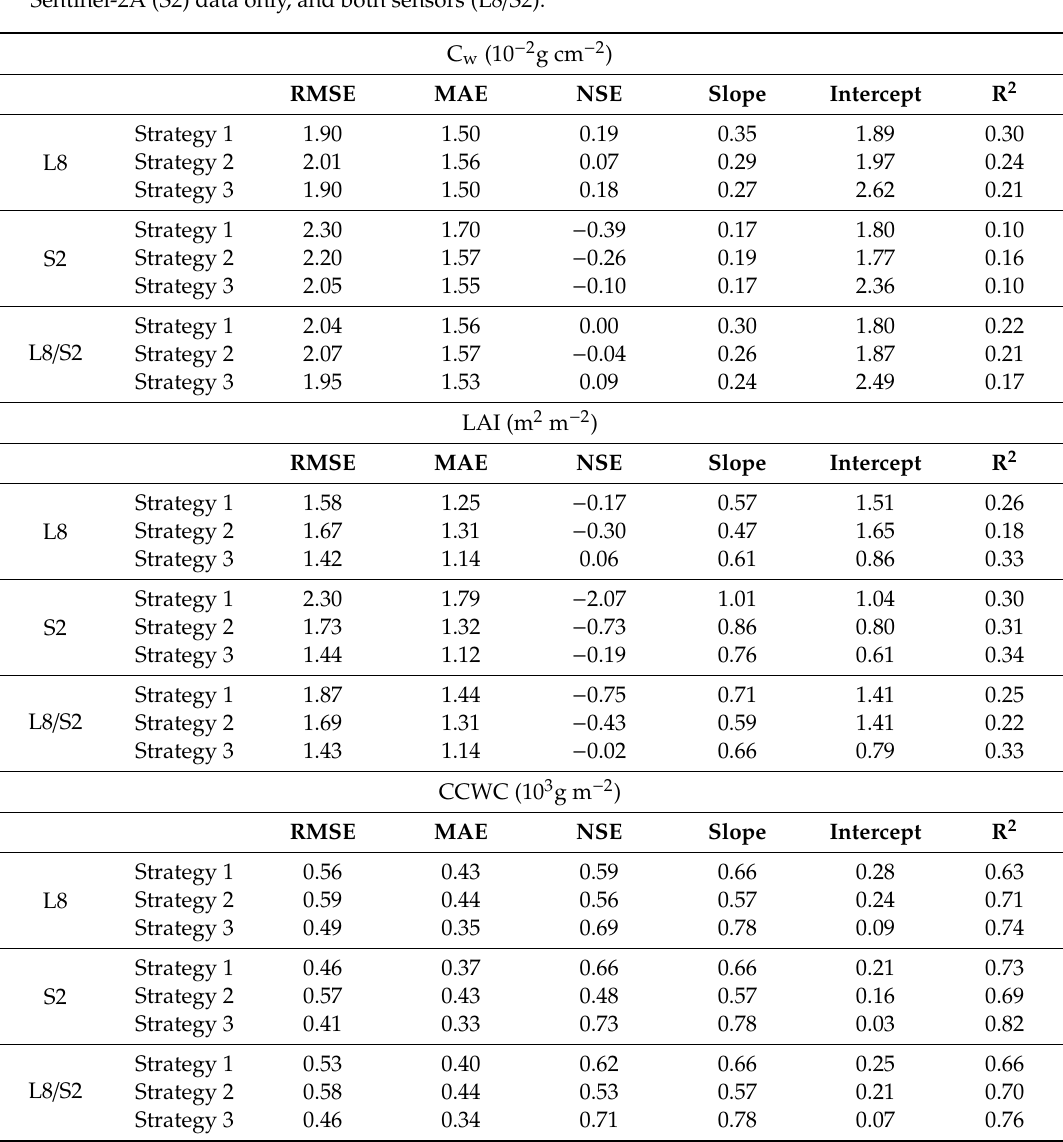
Table 8. Regression and validation metrics for LAI , C w , and CCWC estimated through the three inversion strategies. The table presents the results obtained considering Landsat-8 (L8) data only, Sentinel-2A (S2) data only, and both sensors (L8 /